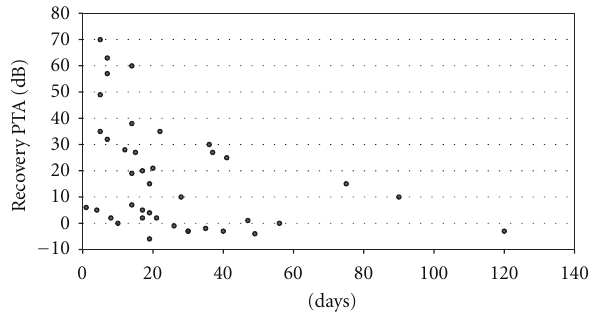
Figure 2: Scatterplot: duration of deafness prior to first dose of intratympanic steroids (ITSs) and degree of hearing recovery in decibels